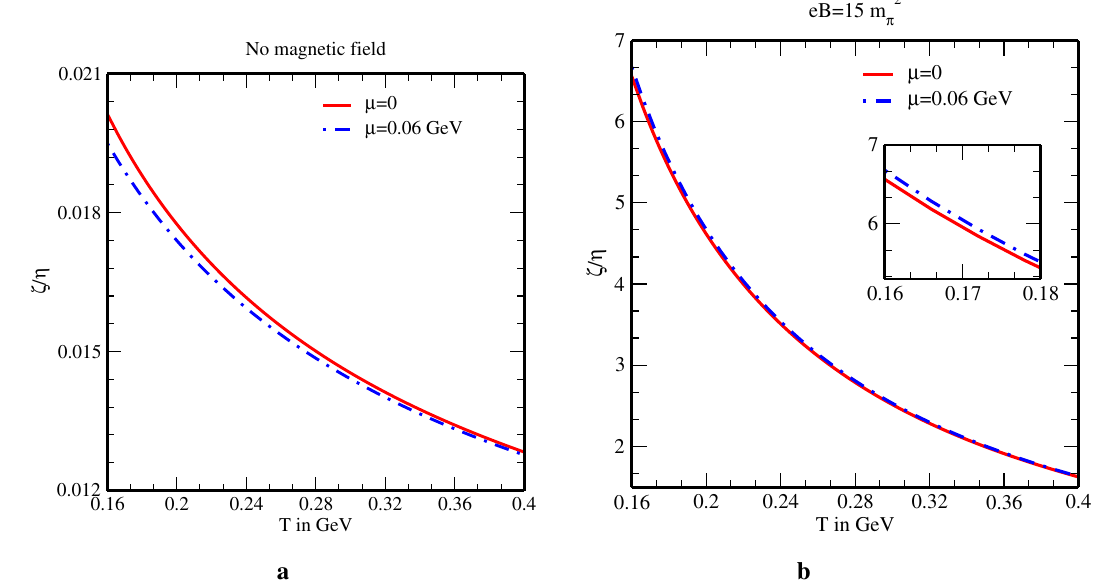
Fig. 7 Variations of ζ/η with temperature in the a absence and b presence of strong magnetic field